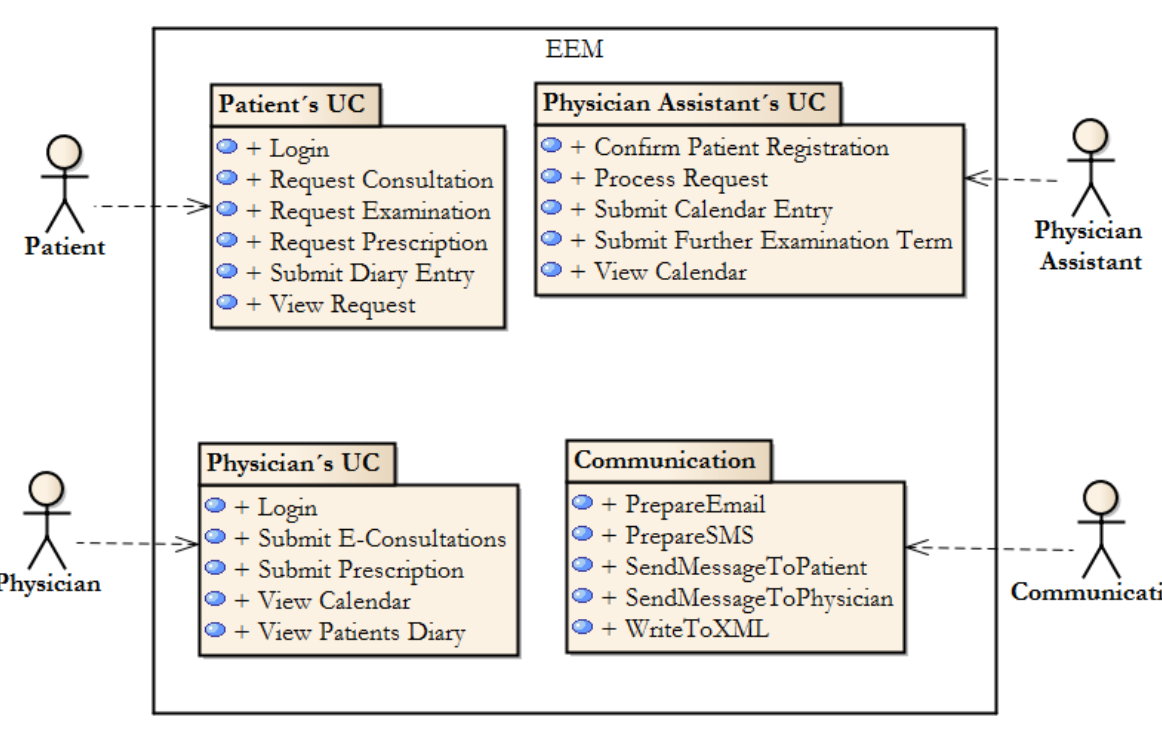
Figure 2. Primary use cases’ packages, which are used in